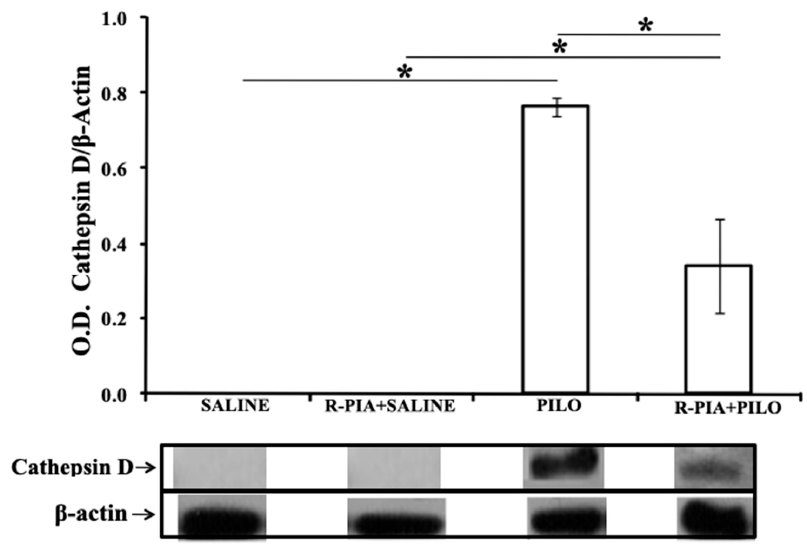
Figure 5. Expression of cathepsin D in the hippocampal samples of rats from all studied groups. Bars represent the mean ± standard deviation of optical density for each group ( N = 4/group), normalized to β -actin levels. * p < 0.03 (Wilcoxon).